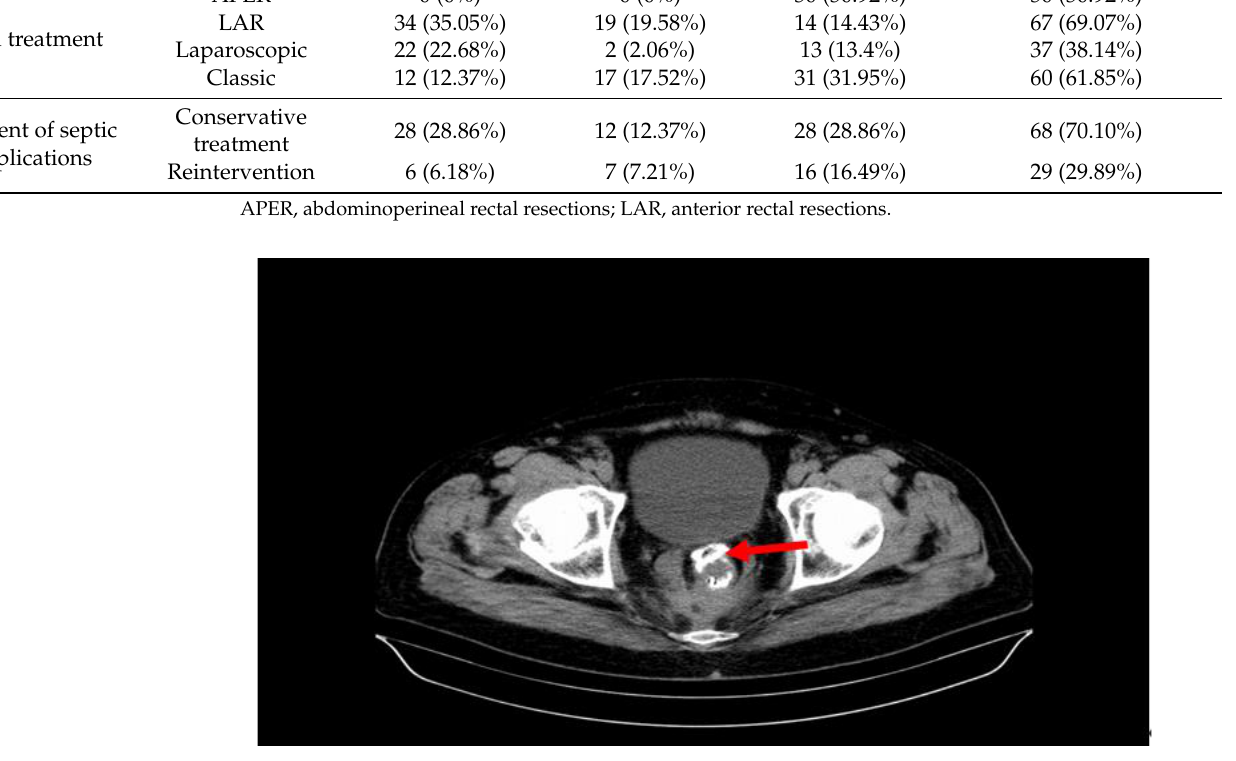
Table 3. Odd ratios of AF vs. A in the sample of patients with complications.